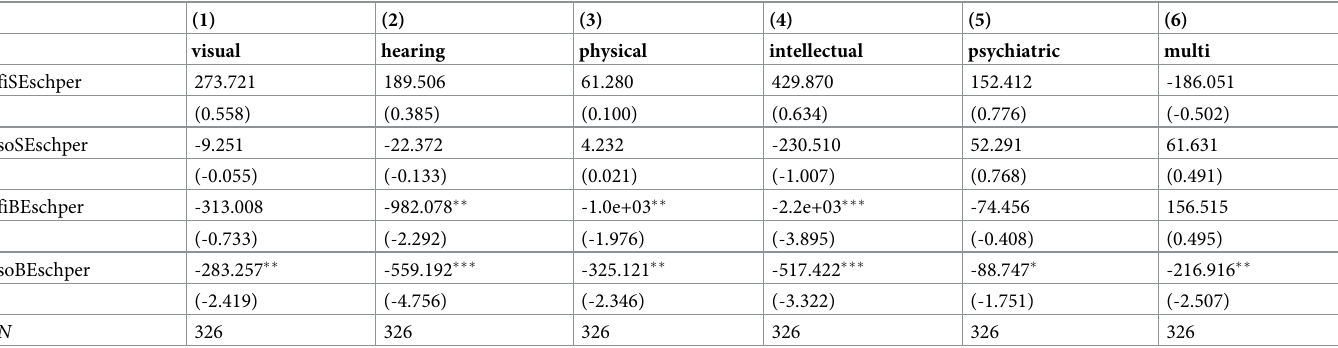
Table 10. The results of scholarship expenditures on subtypes of RSE correction.